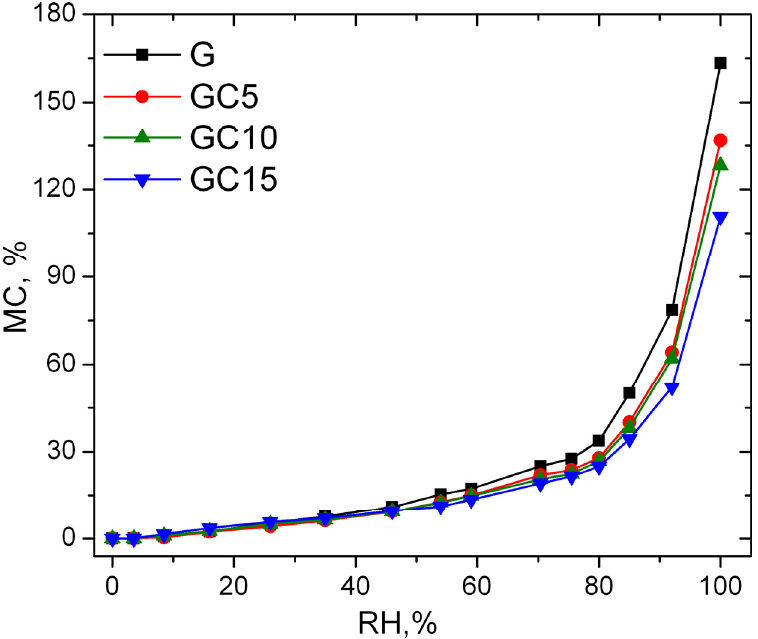
Figure 5. Sorption isotherms of the samples as a function of RH.